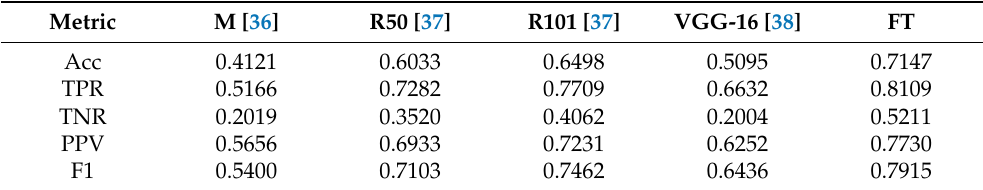
Table 1. Performance comparison on GDXray. The proposed framework with ResNet101 [37] achieved comparable performance to the fine-tuned model.